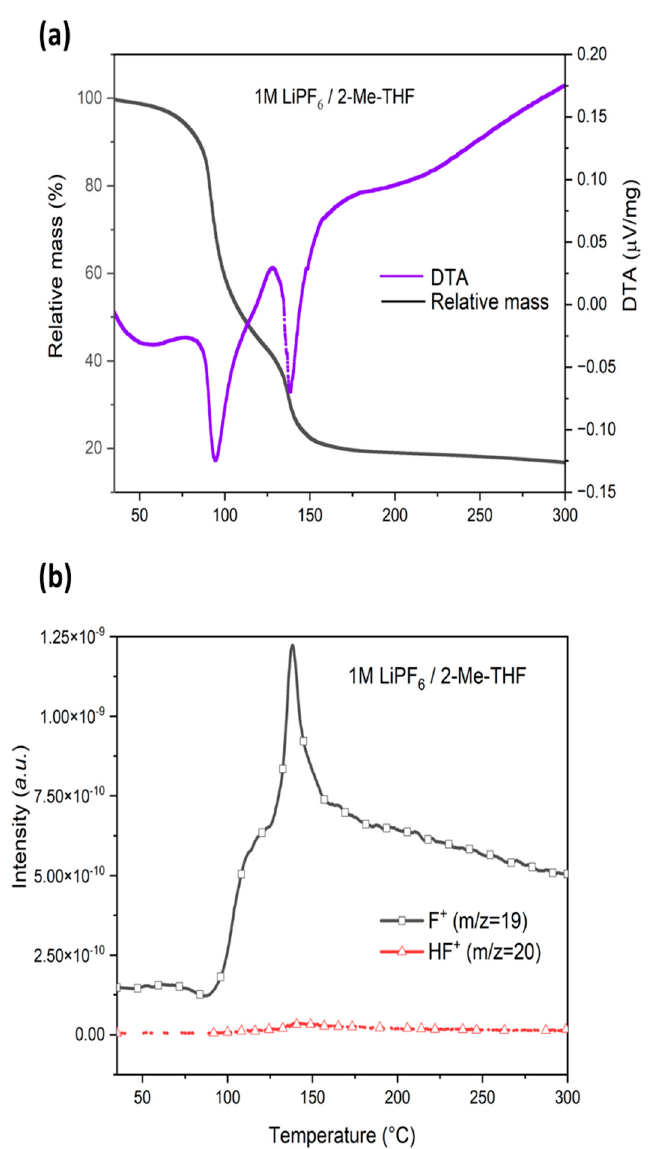
Figure 7. ( a ) TG/DTA curves of HF generation temperature in 1 M LiPF 6 /2-ME-THF electrolyte solution without water, and ( b ) the simultaneous F + and HF + identification using